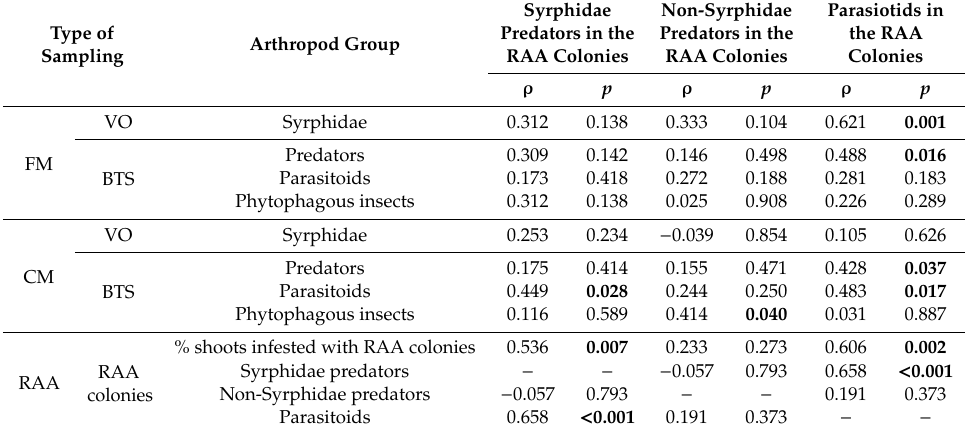
Table 3. Spearman correlation coe ffi cients ( ρ ) between the percentage of infested shoots and the number of natural enemies (Syrphidae predators, non-Syrphidae predators and parasitoids) found in the RAA colonies and the number of arthropods found in visual observations (VO) and beating tray samplings (BTS) in the flower margin (FM) and control margin